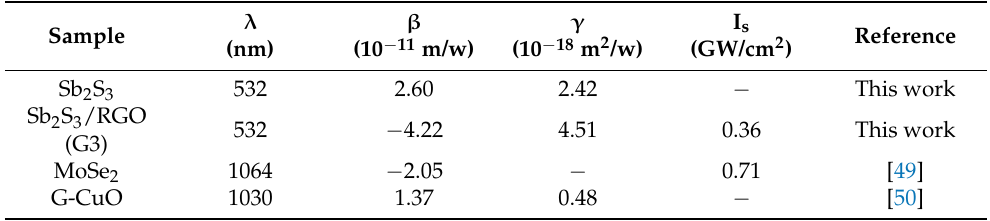
Table 2. The relevant nonlinear parameters of different